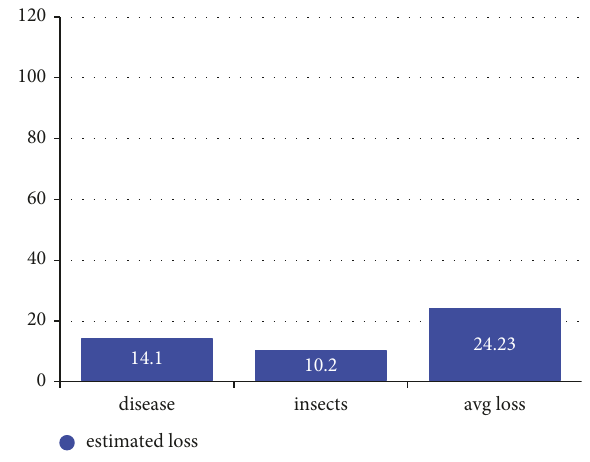
Figure 1: Annual rate of crop